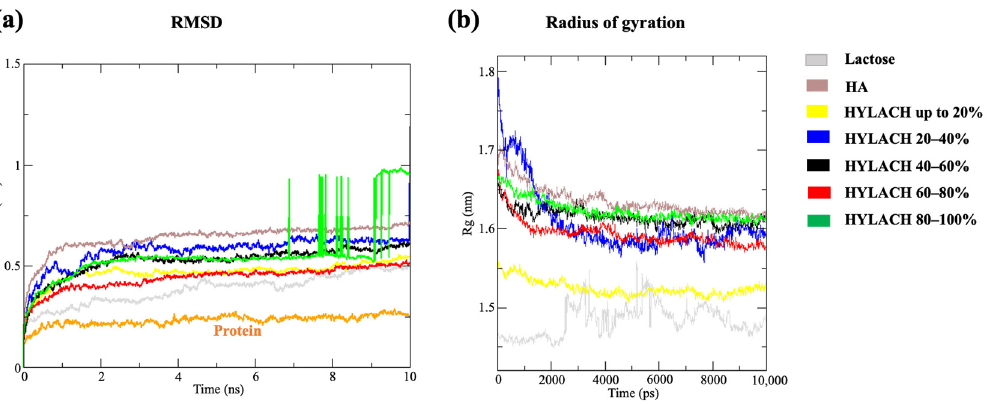
Figure 1. RMSD and Radius of gyration results. ( a ) The protein-associated RMSD curve is highlighted in orange and represents the most stable and equilibrated system, with an RMSD of 1.5 Å. Lactose, HYLACH of up to 20%, and HYLACH from 60 to 80% lactosylation were the systems that most closely resembled the unbound protein’s configuration. Rather, the system formed by Gal-3 and HA differed the most from the protein’s configuration. ( b ) The most structurally stable and compact system was the one containing lactose, even though the trend of the radius of gyration is not linear. Next, the most stable systems were Gal-3 and HYLACH of up to 20% and HYLACH of 20 to 40% lactosylation. The least compact was the protein–HA system with a radius of gyration of about 1.65 nm.